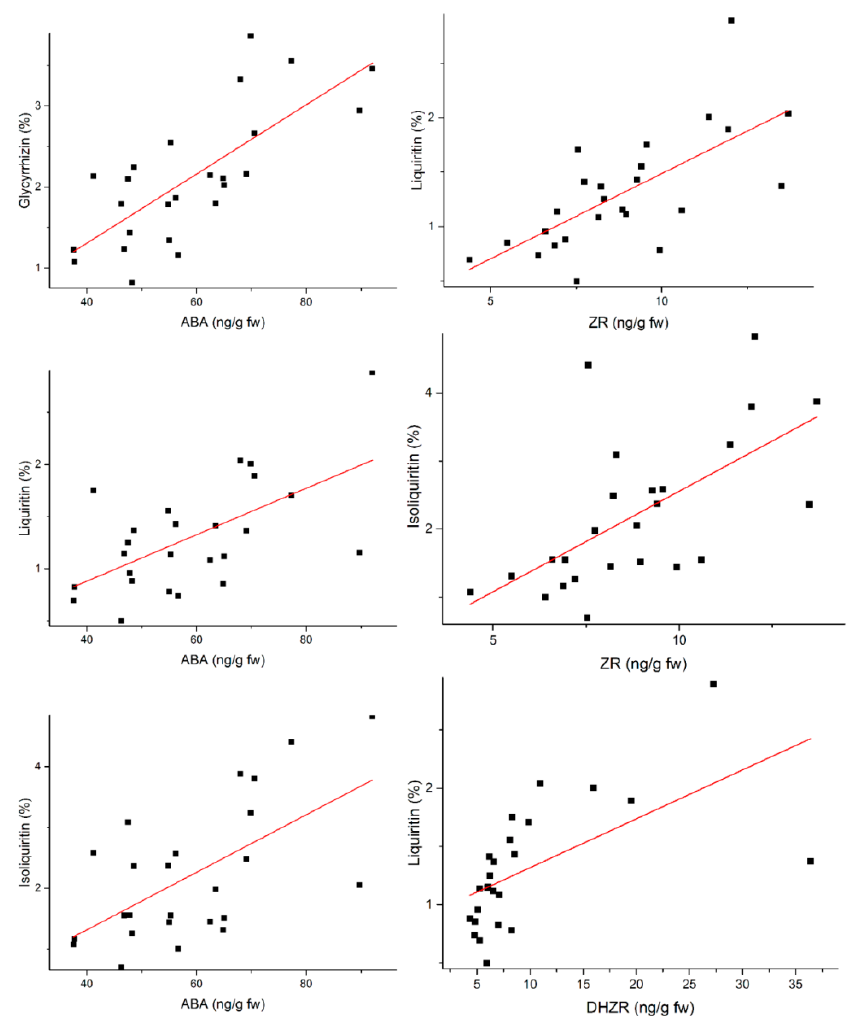
Figure 2. Scatter plot of the correlation between active compounds and phytohormones. Table 2. Correlation between five active components and seven phytohormones in root of G. uralensis from 25 plants.